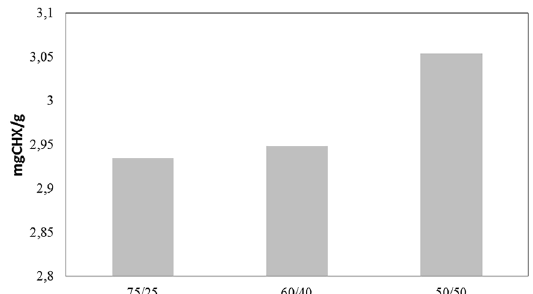
Figure 2. CHX absorption by SPHB-Chi